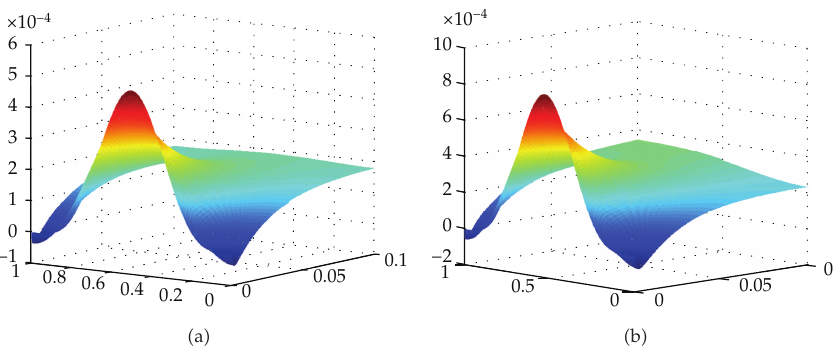
Figure 2: The development of the solution of the full-discrete scheme with initial value u 0 (cid:7) x (cid:8) (cid:9) x 5 (cid:7) 1 − x (cid:8) 5 (cid:7) a (cid:8) and u (cid:7) x (cid:8) (cid:9) x 5 (cid:7) 1 − x (cid:8) 5 e x (cid:7) b (cid:8) . 0